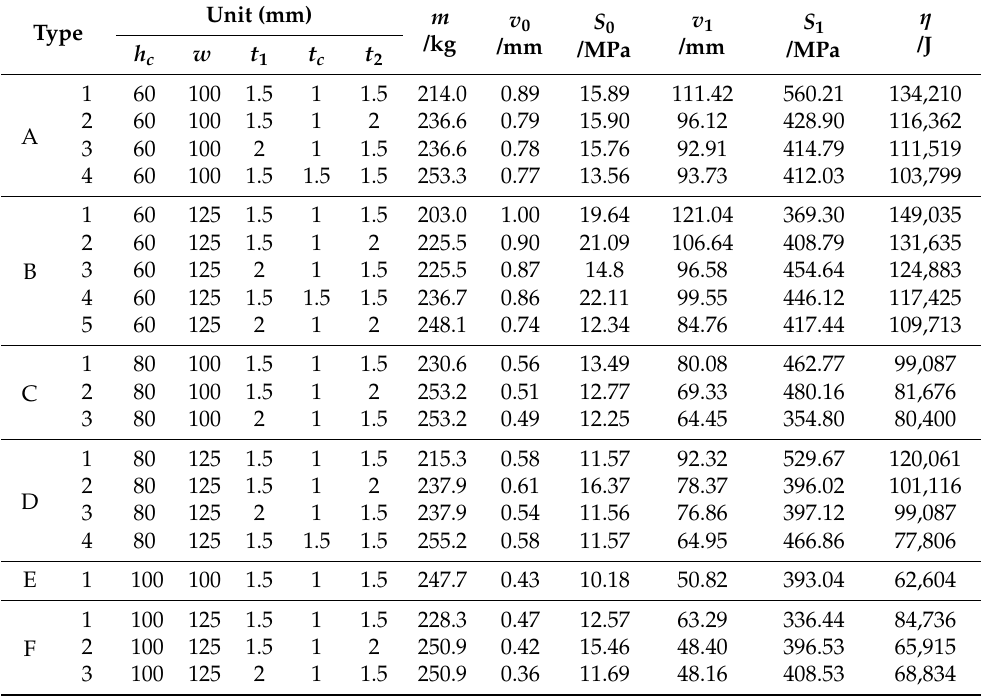
Table 4. Results of simulation calculation under static and impact